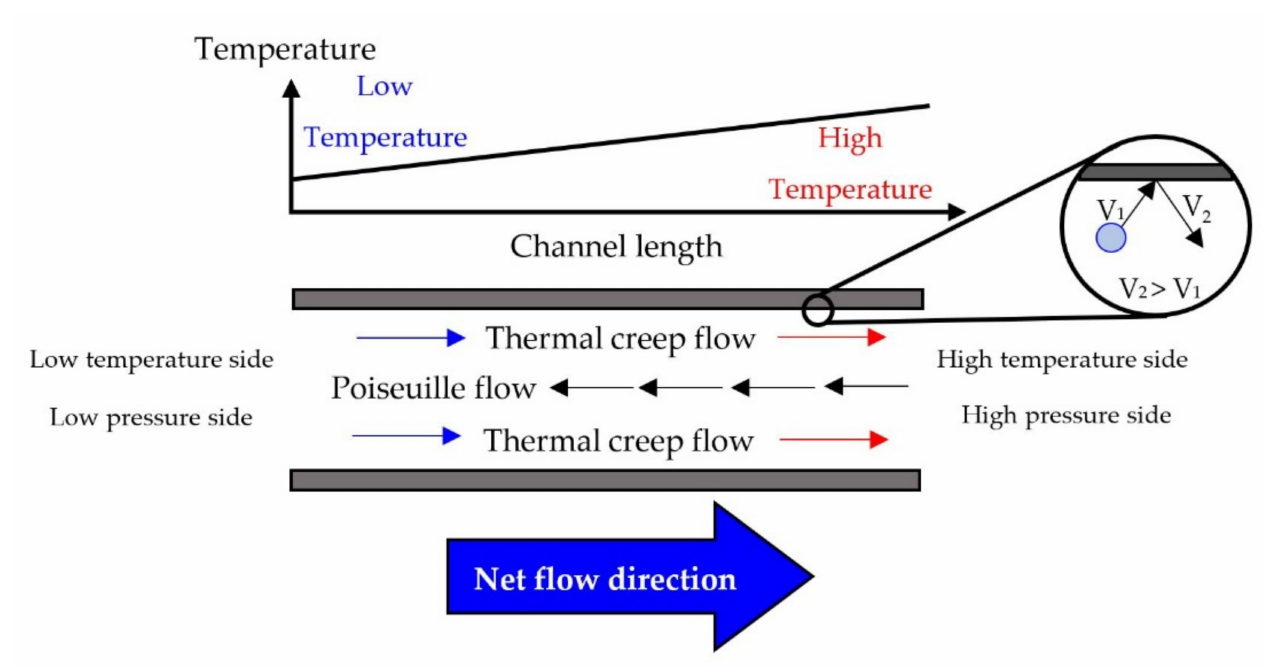
Figure 1. Thermal creep flow and Poiseuille flow in a narrow